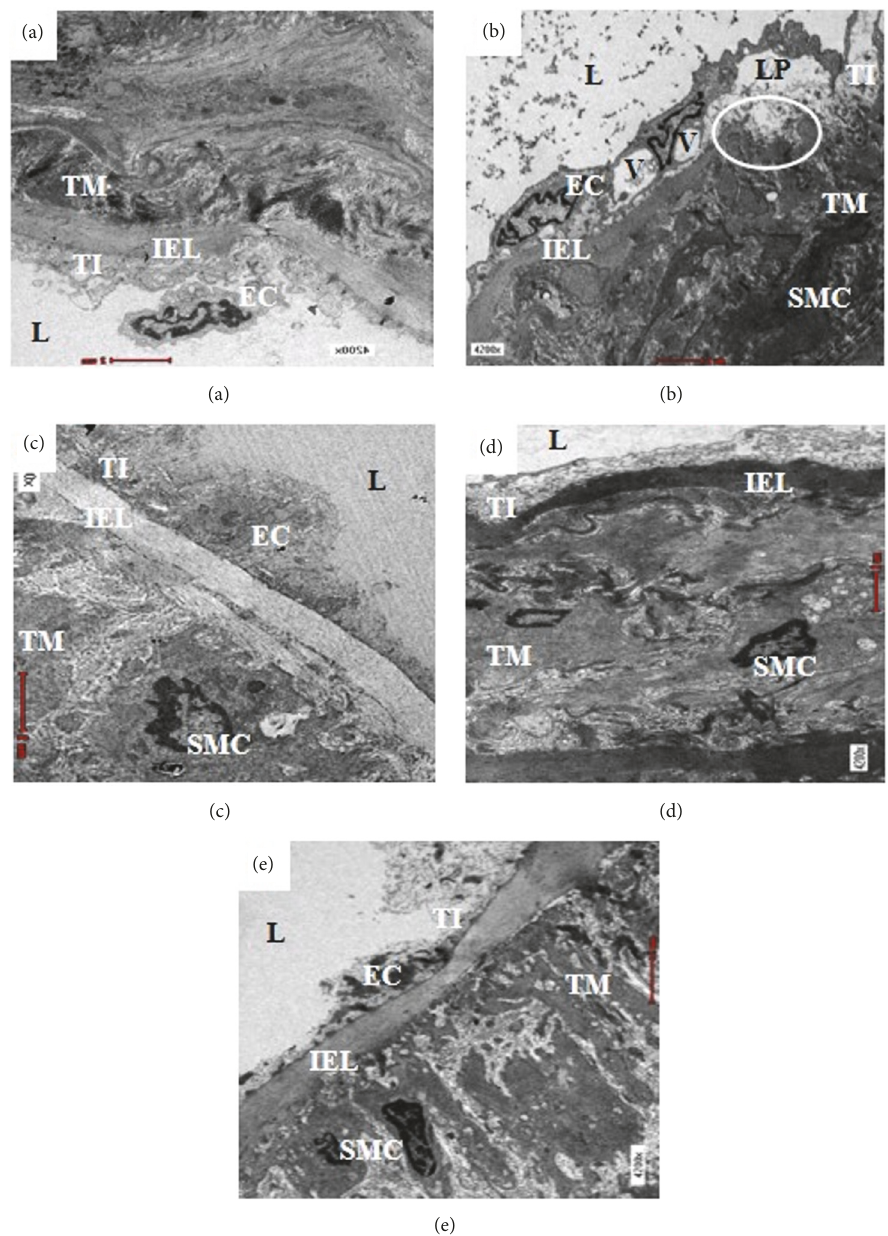
Figure 3: Electron micrograph showing ultrastructure of the thoracic aorta of (a) Sham, (b) OVX, (c) OVX+ST, (d) OVX+MCLD, and (e) OVX+MCHD. Vacuolation (V) and lipid accumulation (LP) were noted in (b) OVX, also disruption of internal elastic lamina (IEL) with migrationofsmoothmusclecell(SMC)fromthetunicamedia(TM)intotunicaintima(TI).Thelumen(L)of(b)OVXisfilledwithnumerous granular substances, which was not seen in other groups. EM